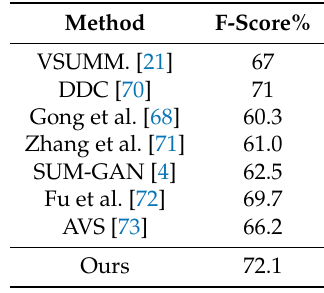
Table 2. Comparison of our proposed key frame detection approach compared to several state of the art